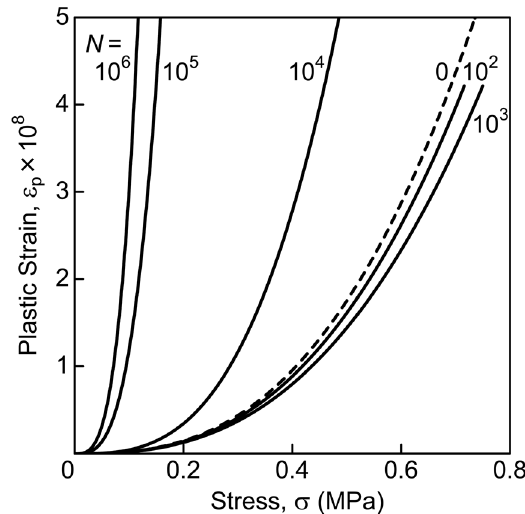
expressed as a function of effective Figure 4. Microplastic strain ε p stress σ in CFRP laminates subjected to fatigue cycling of N = 10 2 - 10 6 and undeformed ( N = 0)